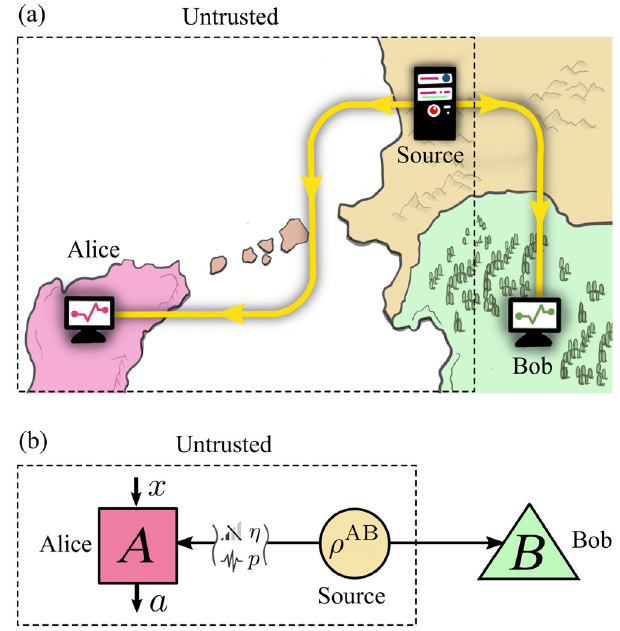
FIG. 1. 1SDI entanglement distribution scenario. The illustra- tion in (a) depicts an example of a fiber-based 1SDI quantum network between two distant stations, Alice and Bob. A source distributes entangled photon pairs to Alice and Bob via optical fiber links. In the 1SDI scenario, the source, Alice ’ s base station, and the fiber link between them are untrusted, for example, due to their geographic location or compromised devices. On the other hand, Bob ’ s station is trusted, and hence, imperfections on his side are ignored. A suitable strategy to certify entanglement in this scenario is given by quantum steering (b), where a bipartite state ρ AB is shared between Alice and Bob. Alice ’ s measurements and the channel between her and the source are affected by loss ( η ) and noise ( p ) and considered to be untrusted. By performing local measurements x with outcomes a , Alice conditions the shared state ρ AB to an assemblage σ a at Bob. Bob can perform j x suitable measurements on his shared state and check if the state is steerable (thus, entangled) by violating a steering